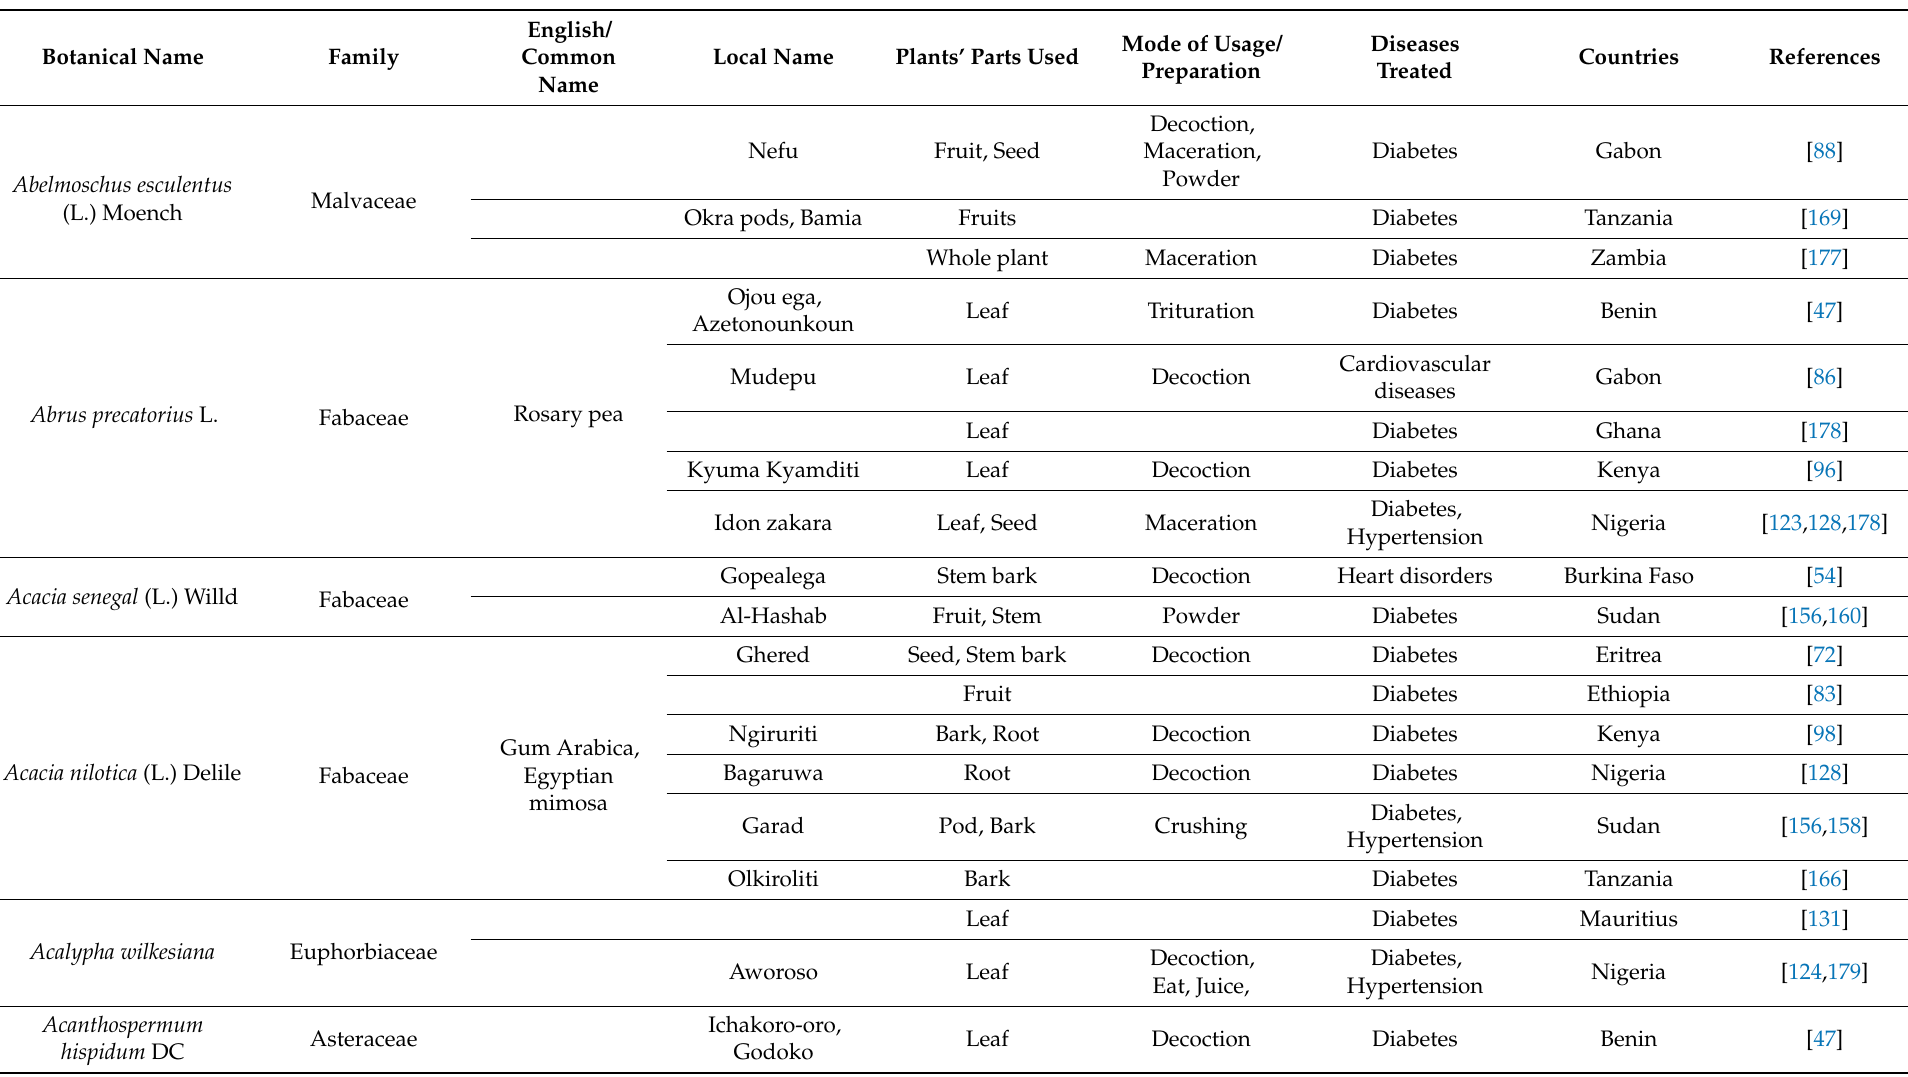
Table 2. Medicinal plants used for the treatment of cardiovascular diseases and their associated risk factors in two or more sub-Saharan African